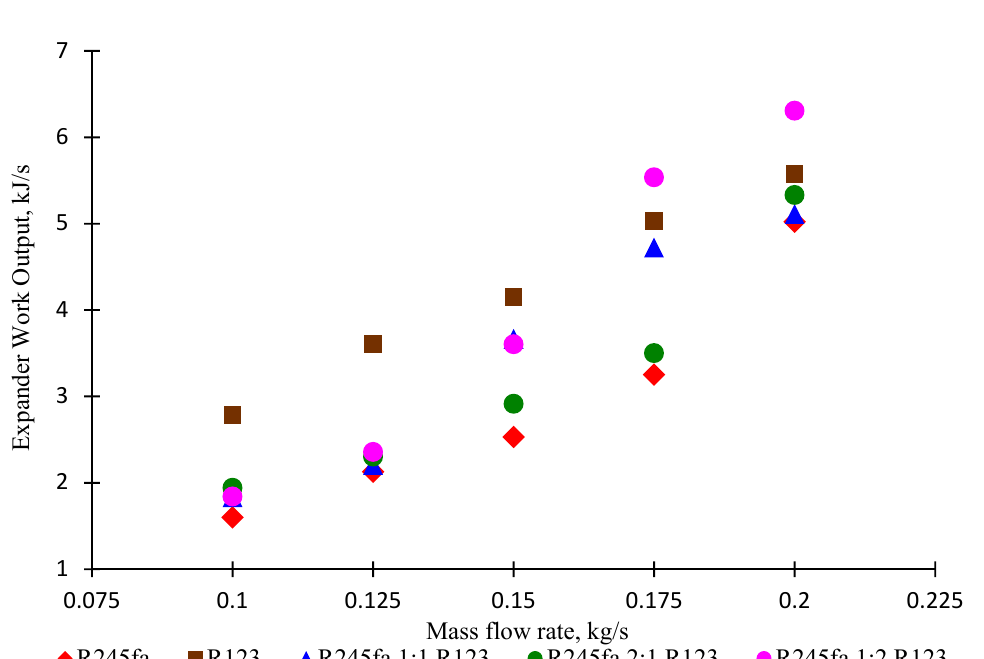
Figure 12. Expander work output as a function mass flow rate for R245fa, R123, and mixed working fluids with heat source at 110 ° C.